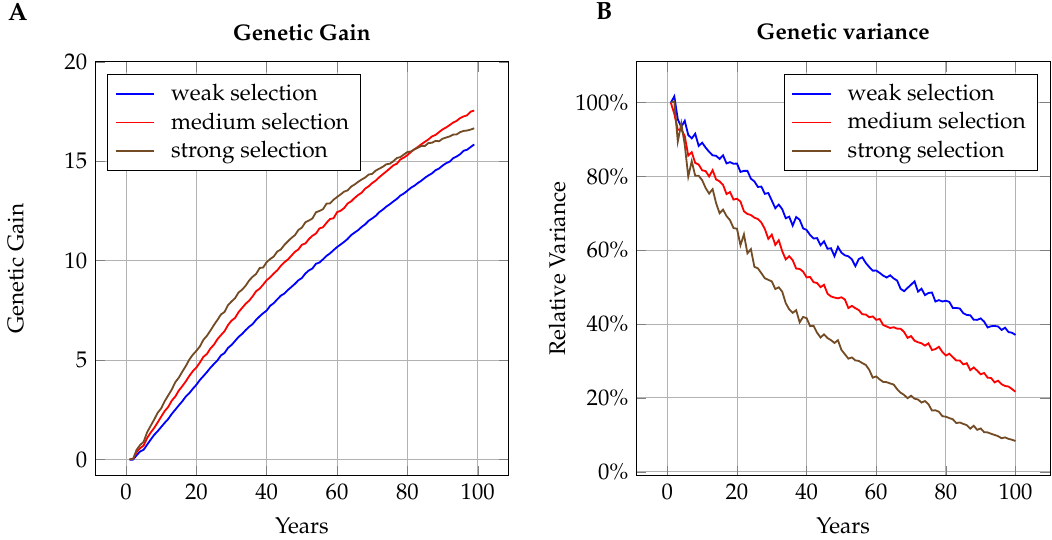
Figure 3. Development of genetic gain ( A ) and genetic variance ( B ) over time for three selection intensities: strong selection ( k d = 9, k s = 1), medium selection ( k d = 4, k s = 6), and weak selection ( k d = 2, k s = 9). Initially, intense selection yields higher rates of genetic gain, but the severe reduction of genetic variance leads to reduced gain in later years. Graphs are shown for a population of 500 queens per year and selection for trait T − 0.53 with 400 influential loci and moderate correlation between effects 400 ( r md = −